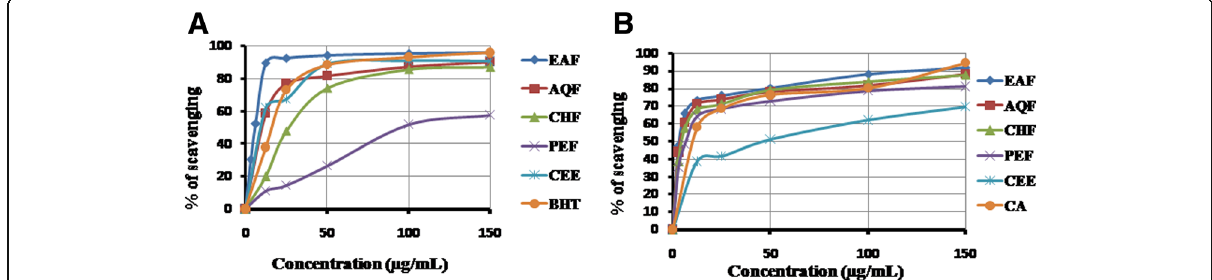
Fig. 2 Determination of ( a ) DPPH radical scavenging activity and ( b ) OH radical scavenging activity of CEE and its various fractions (EAF, AQF, CHF and PEF). Data expressed as mean ± SD (n = 3, p < .01) for all tested